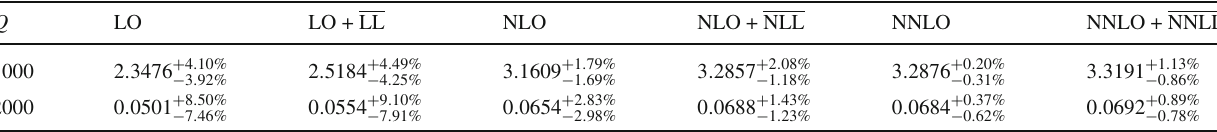
Fig. 3 7-point scale variation of the resummed result against fixed-order around the central scale choice (μ R ,μ F ) = ( 1 , 1 ) Q for 13 TeV LHC. The dashed lines refer to the corresponding central scale Q = μ R = μ F at each order Table 6 Values of resummed cross section in 10 − 5 pb/GeV at various orders in comparison to the fixed-order results at different central scales Q = μ R = μ F = 1000 and 2000 GeV for 13 TeV